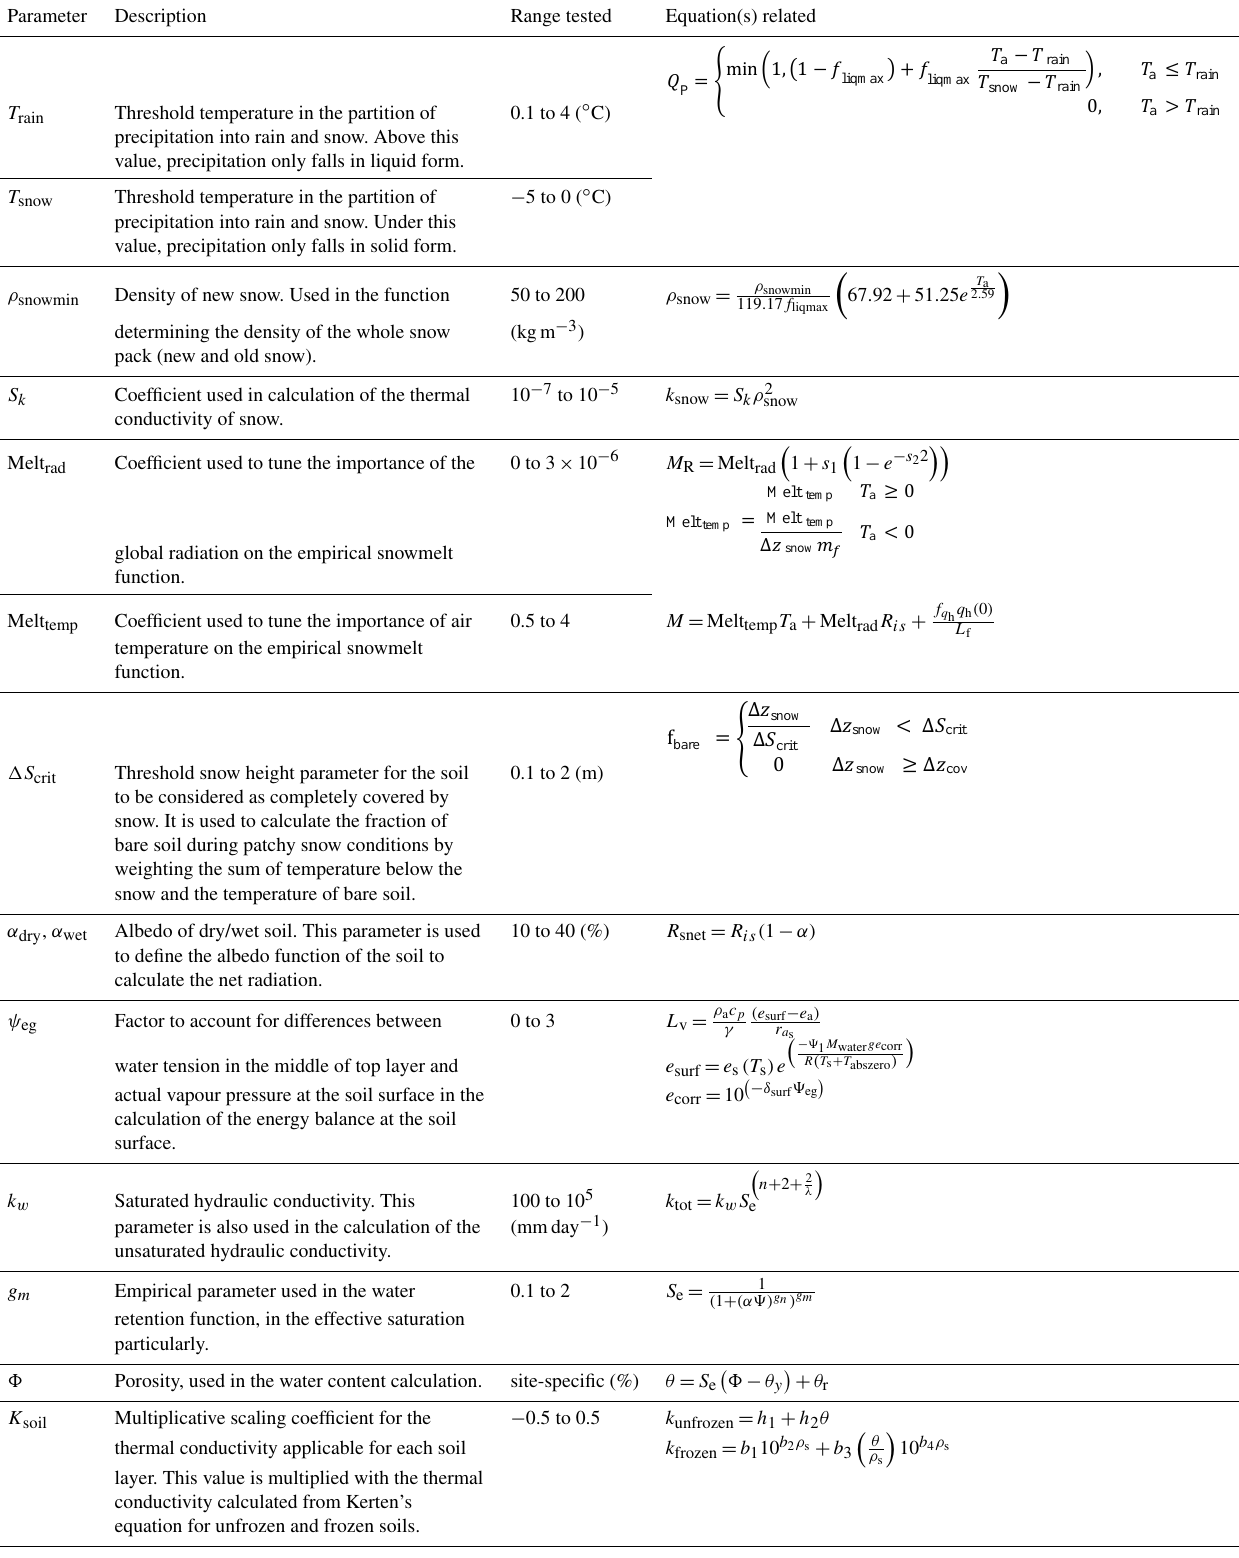
Table 2. List of parameters used in the GLUE calibration method and their corresponding equations. Parameter Description Range